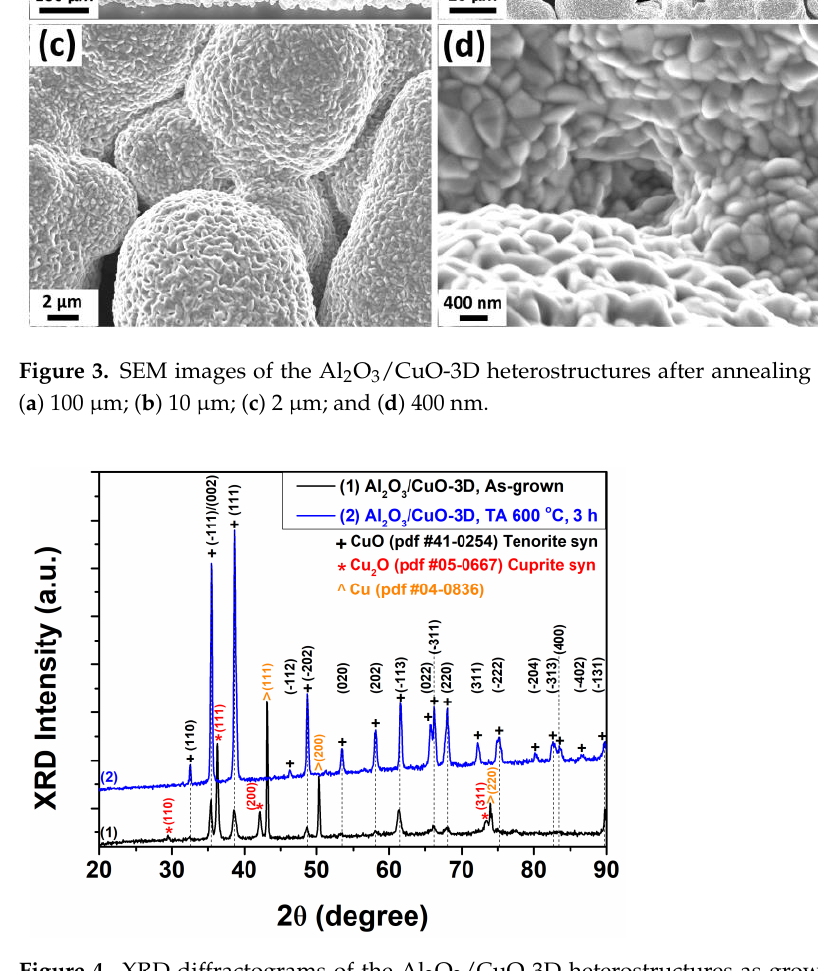
Figure 4. XRD diffractograms of the Al 2 O 3 /CuO-3D heterostructures as-grown and after TA at 600 ◦ C for 3 h in normal ambient